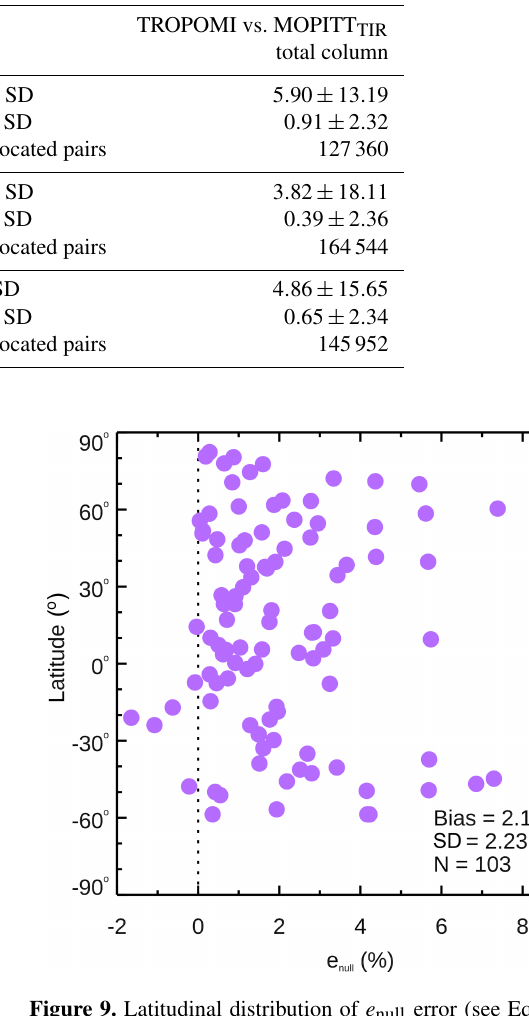
Figure 9. Latitudinal distribution of e null error (see Eq. 4), which characterizes retrieval errors over cloudy scenes related to the shape of the TROPOMI model-calculated reference profiles, expressed in percentage with respect to the true (unsmoothed) ATom-4 total CO